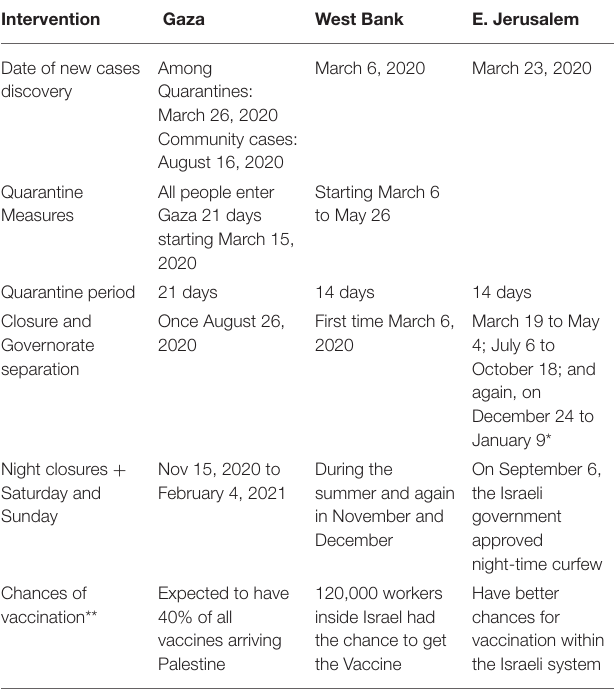
TABLE 3 | Summary of the interventions for COVID-19 for the three territories.